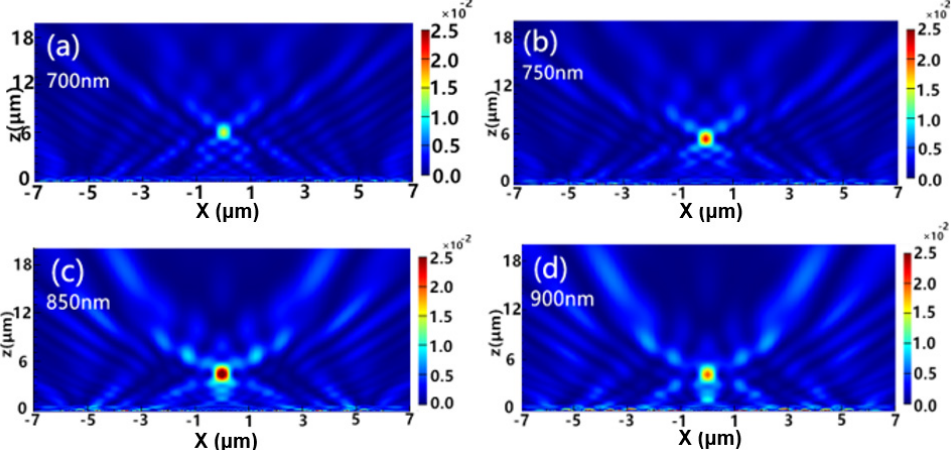
Figure 6. The Poynting vector of the reflected light fields for the metalens with incidence wavelength of ( a ) 700 nm, ( b ) 750 nm, ( c ) 850 nm, and ( d ) 900 nm.